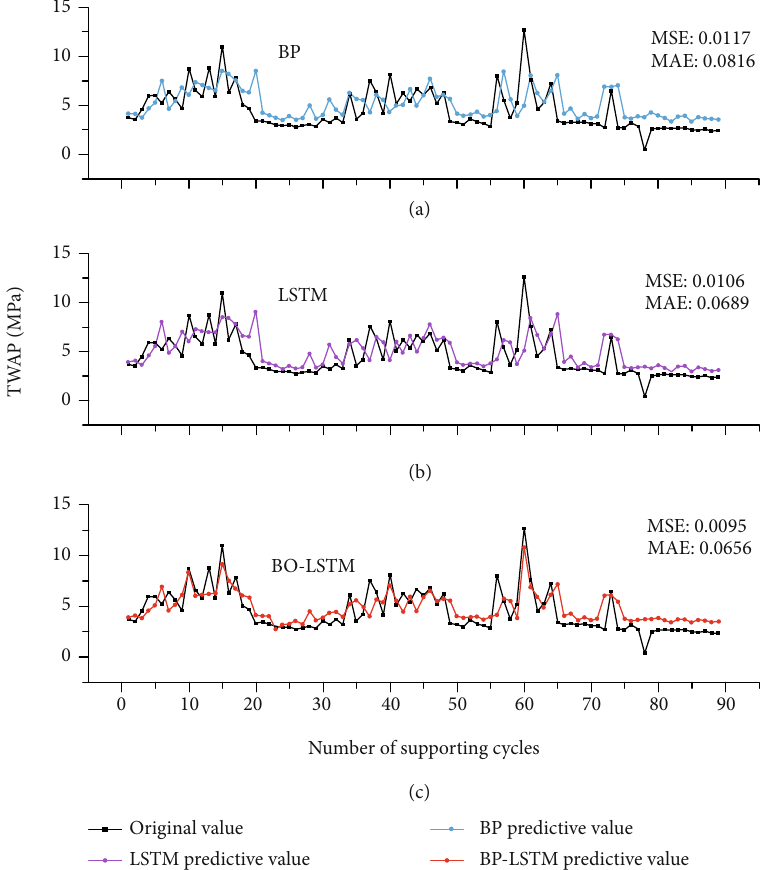
Figure 10: Comparison among the TWAP prediction performances of three models for 1#